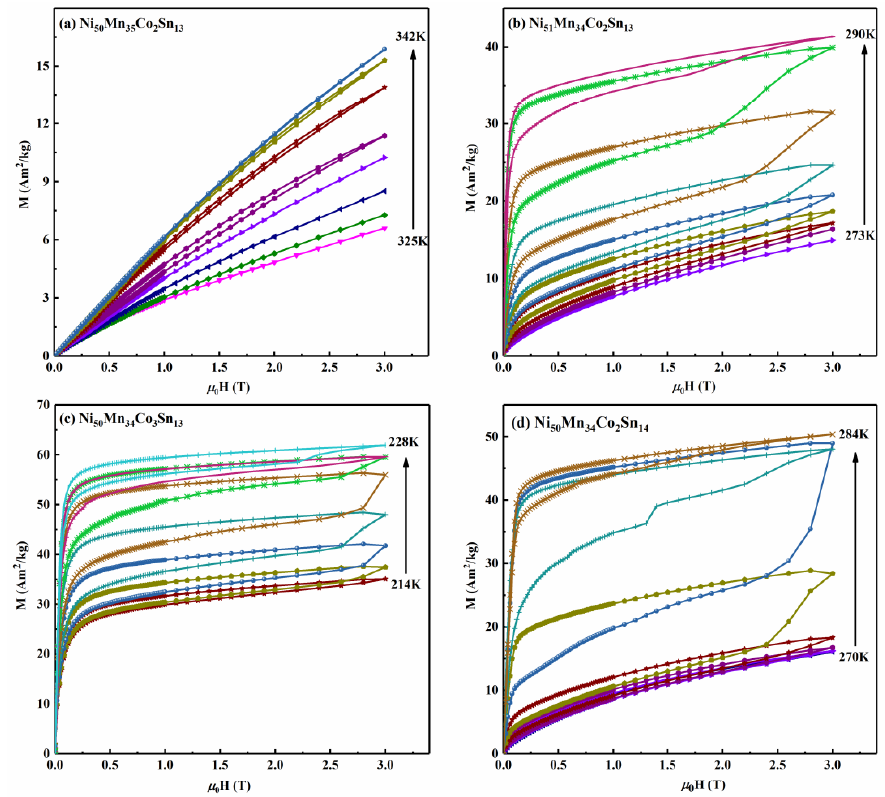
Figure 4. Magnetization isotherms of Ni-Mn-Co-Sn alloys with increasing temperatures upon field ascending and descending modes.